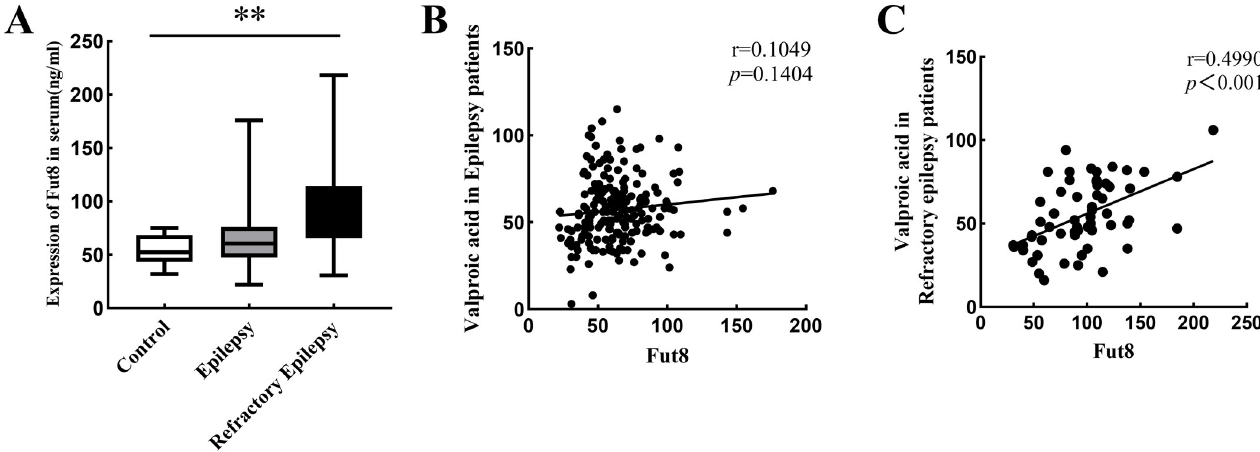
Fig 3. Correlation between serum Fut8 expression and valproic acid concentration. A . The expression of Fut8 in three groups were detected by ELISA. B . Pearson Correlation analyzed the correlation between Fut8 and valproic acid in epilepsy patients. C . Pearson Correlation analyzed the correlation between Fut8 and valproic acid in refractory epilepsy patients. * indicated p < 0.05, ** indicated p < 0.01.